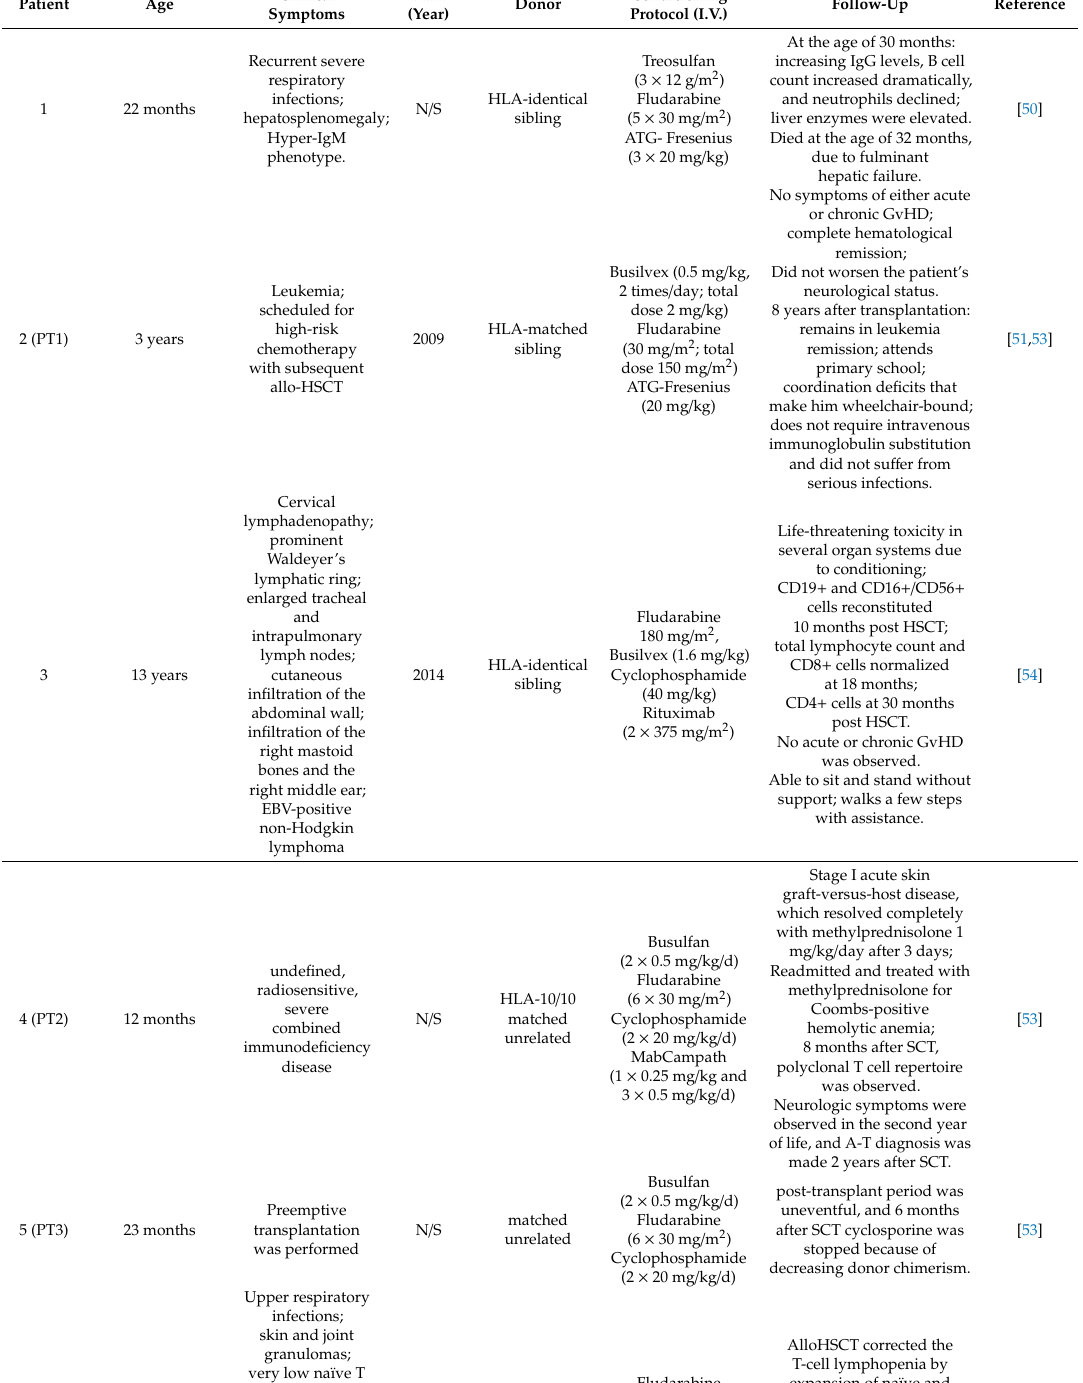
Table 1. Bone marrow transplantation in A-T